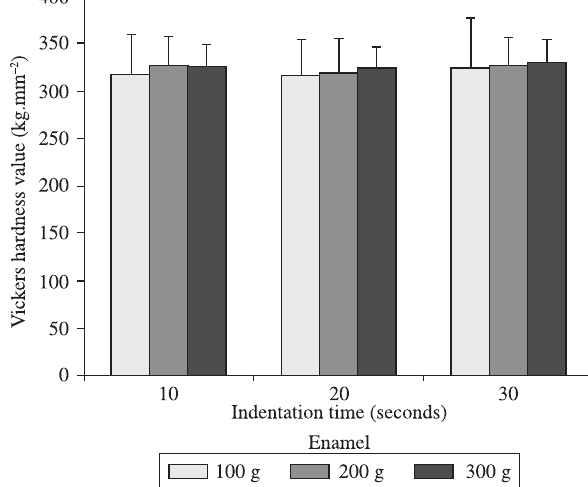
Figure 3. Average VHN values (SD) of enamel at different indentation loads and times.